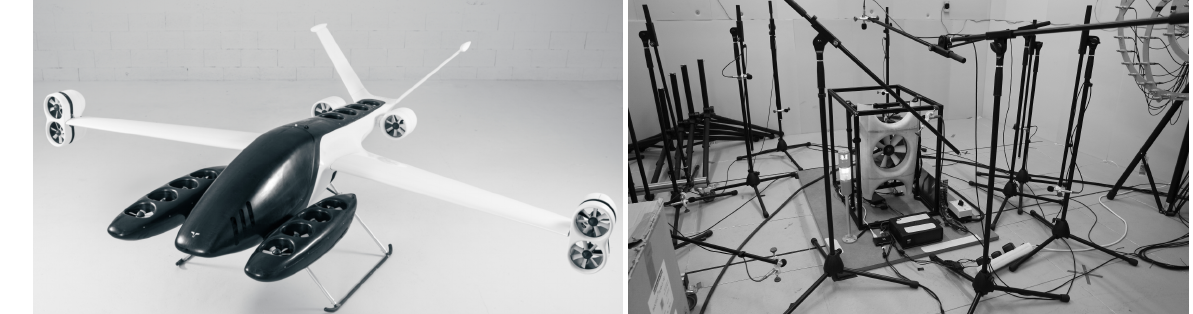
Figure 2. The device under test during the measurement campaign ( right ) is one fan of the propulsion assemblies, which are arranged left and right of the fuselage of the APELEON X1 ( left ).